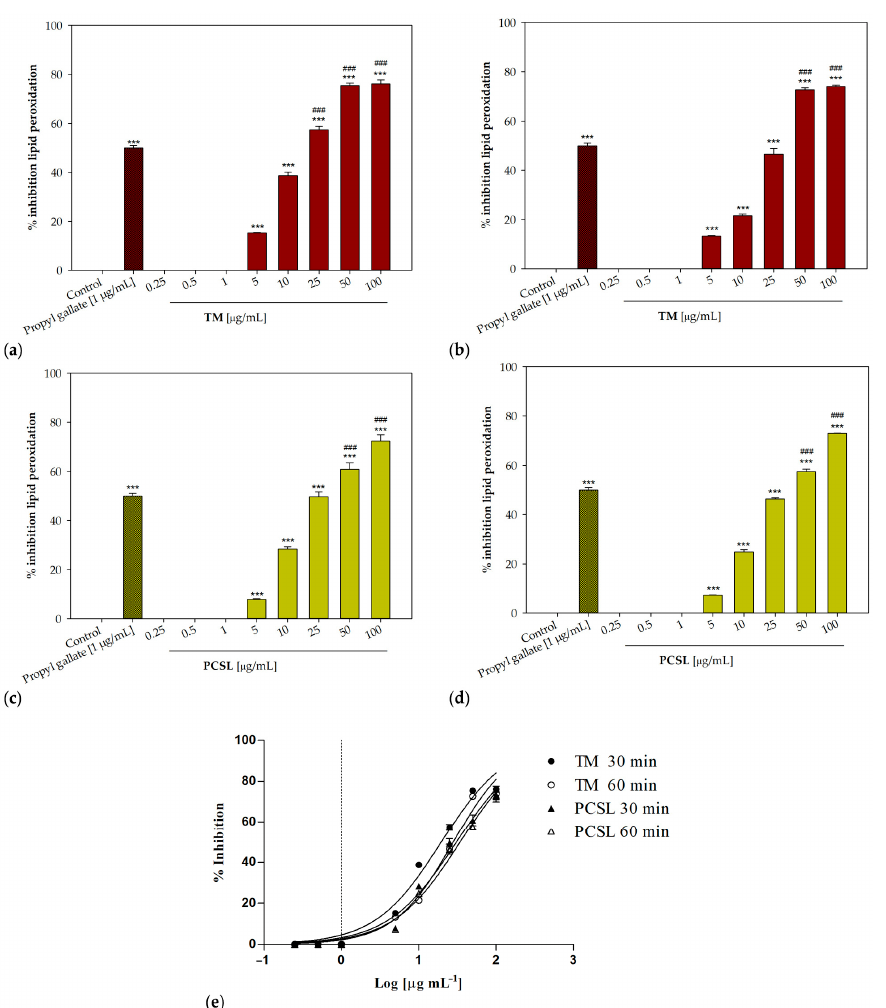
Figure 4. Concentration-dependent inhibition of lipid peroxidation induced by P. ferulacea Lindl. extracts. ( a ) Traditional maceration, TM, 30 min of incubation; ( b ) traditional maceration, TM, 60 min; ( c ) pressurized cyclic solid–liquid extraction, PCSL, 30 min.; ( d ): pressurized cyclic solid– liquid extraction, PCSL, 60 min; ( e ) nonlinear regression analyses; *** p < 0.001 compared to control (Dunnett’s test); ### p < 0.001 compared to positive control (propyl gallate, 1 µ g/mL). Table 4. Photocytotoxic effects of P. ferulacea Lindl. extracts on human melanoma cell line C32.